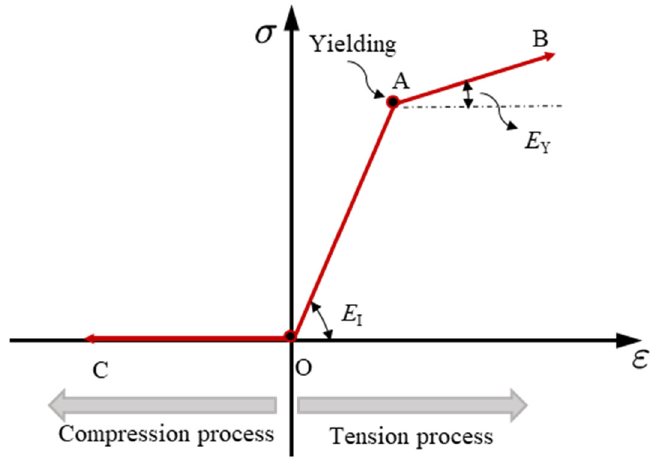
Figure 6. The discretization model of the tower-line system.